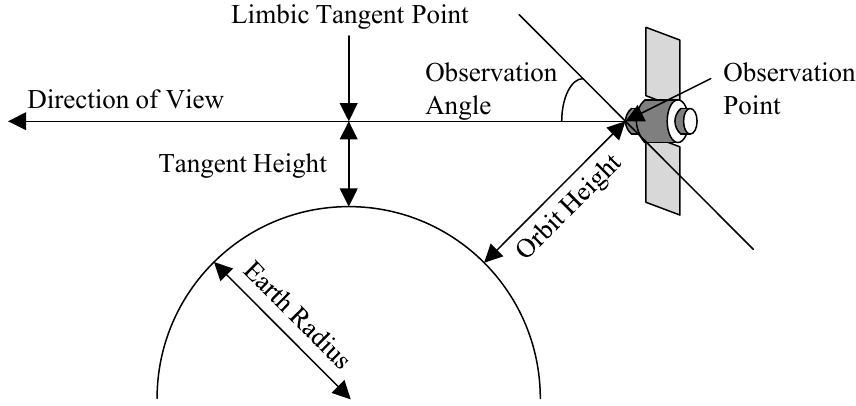
Figure 1. Schematic diagram of limb sounding with TALIS.